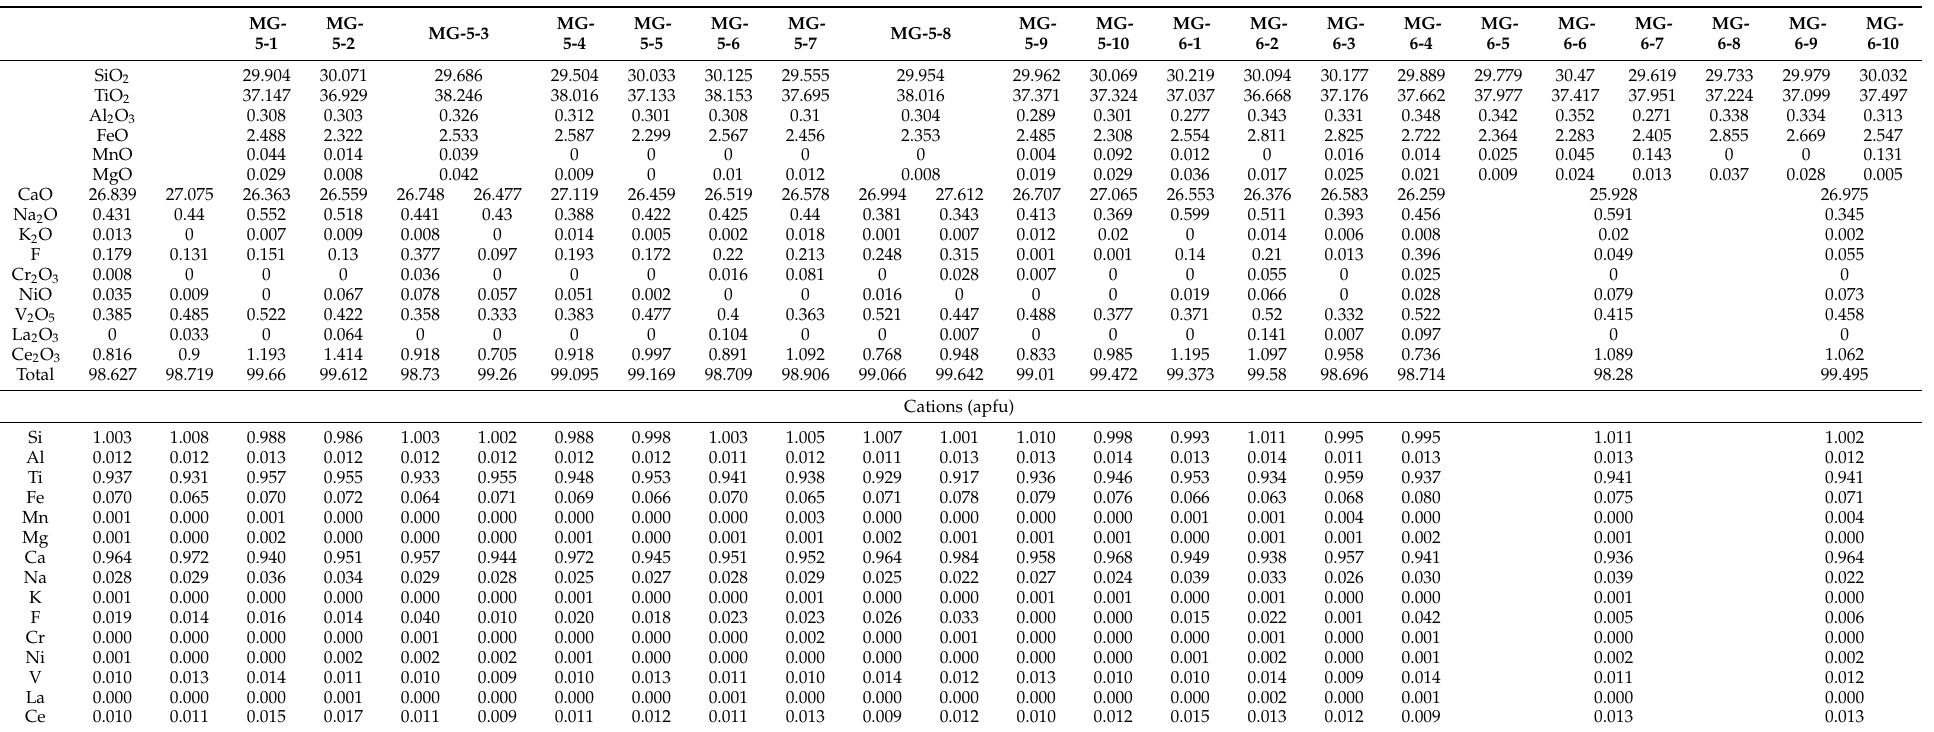
Table 1. Chemical compositions with the structural formulas of analysed titanite from Mogok analysed by EMPA